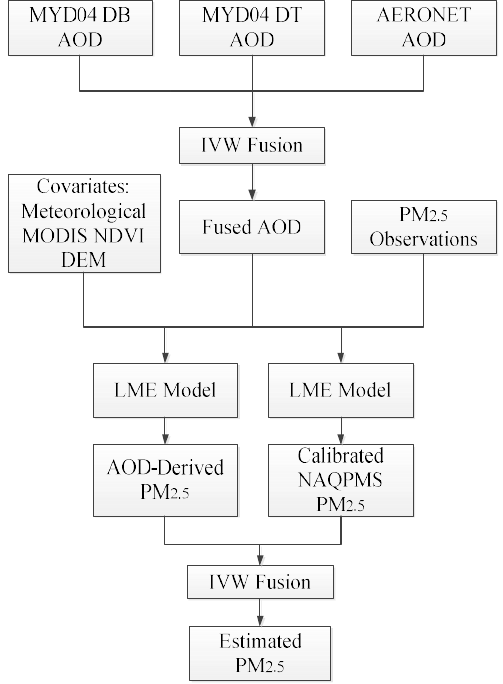
Figure 1. Flowchart of process used to estimate fine ambient particulate matter (PM 2.5 ).